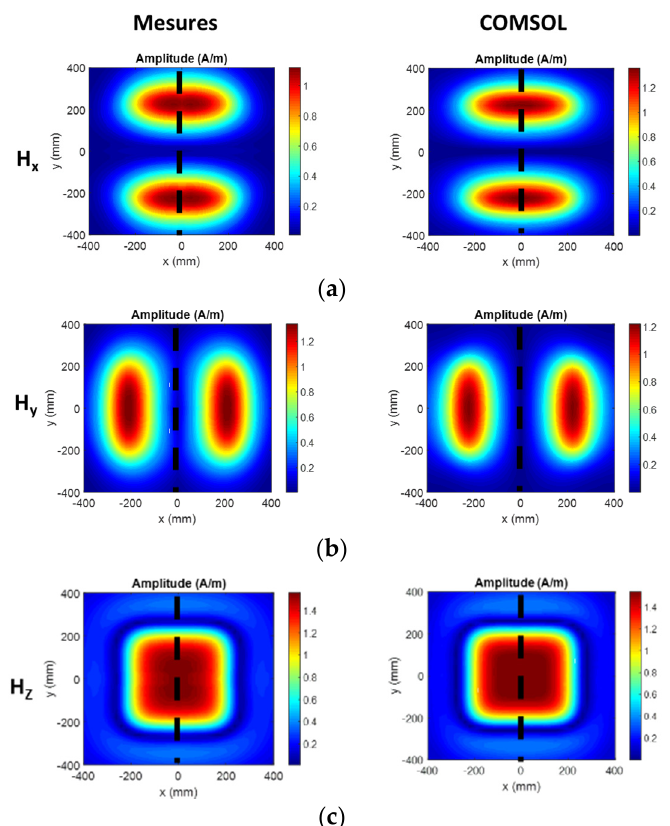
Figure 19. Magnetic field cartographies comparison at a height of 100 mm. ( a ) x component of the magnetic field; ( b ) y component of the magnetic field; ( c ) z component of the magnetic field.